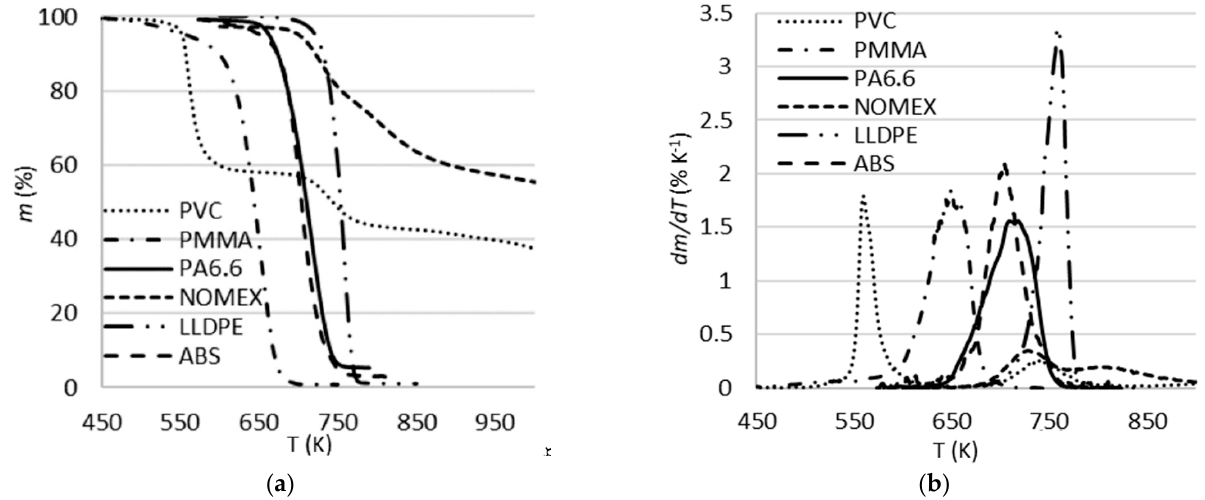
Figure 6. Experimental ( a ) TG and ( b ) dm / dT responses of six polymer materials examined at a heating rate of 10 K min − 1 .